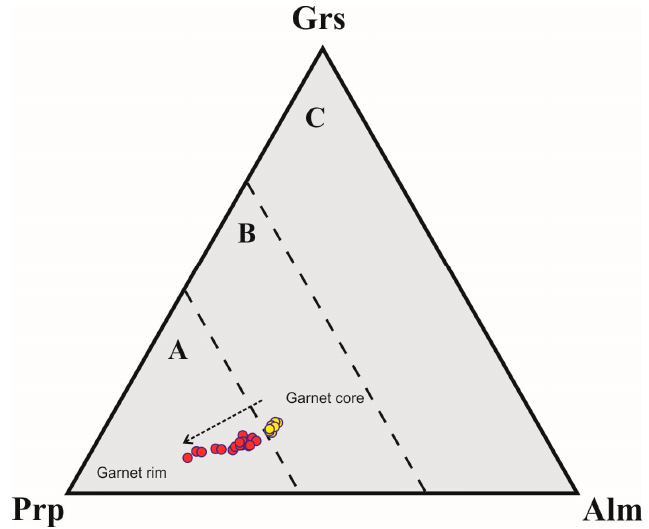
Figure 2. Composition of garnet core (yellow circles) and rim (red circles) from Uv-537 eclogite, from the Udachnaya kimberlite pipe, in ternary diagram (A, B, C) for classification of eclogites [83] (Grs—grossular; Prp—pyrope; Alm—almandine). Dash arrow indicates change of composition of garnet from core (Grt I) to rim (Grt II). Minerals 2019 , 9 , x FOR PEER REVIEW